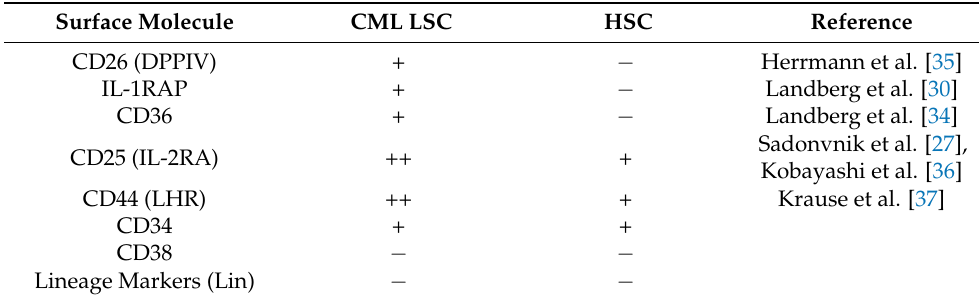
Table 1. Aberrant surface molecule expression in CML LSCs. LSC, leukemia stem cell; HSC, hematopoietic stem